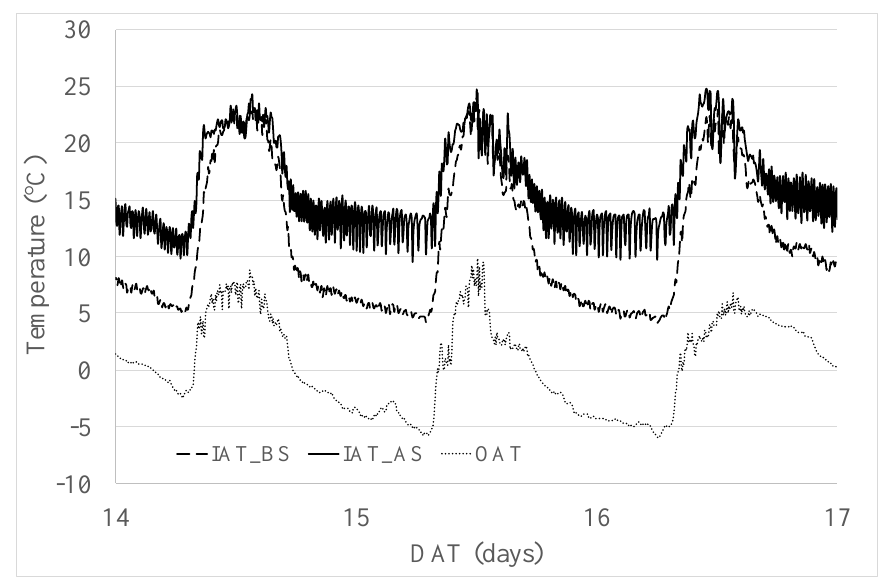
Figure 7. Plot of the greenhouse inner and outer environmental temperatures during the three coldest days of the experimental period.